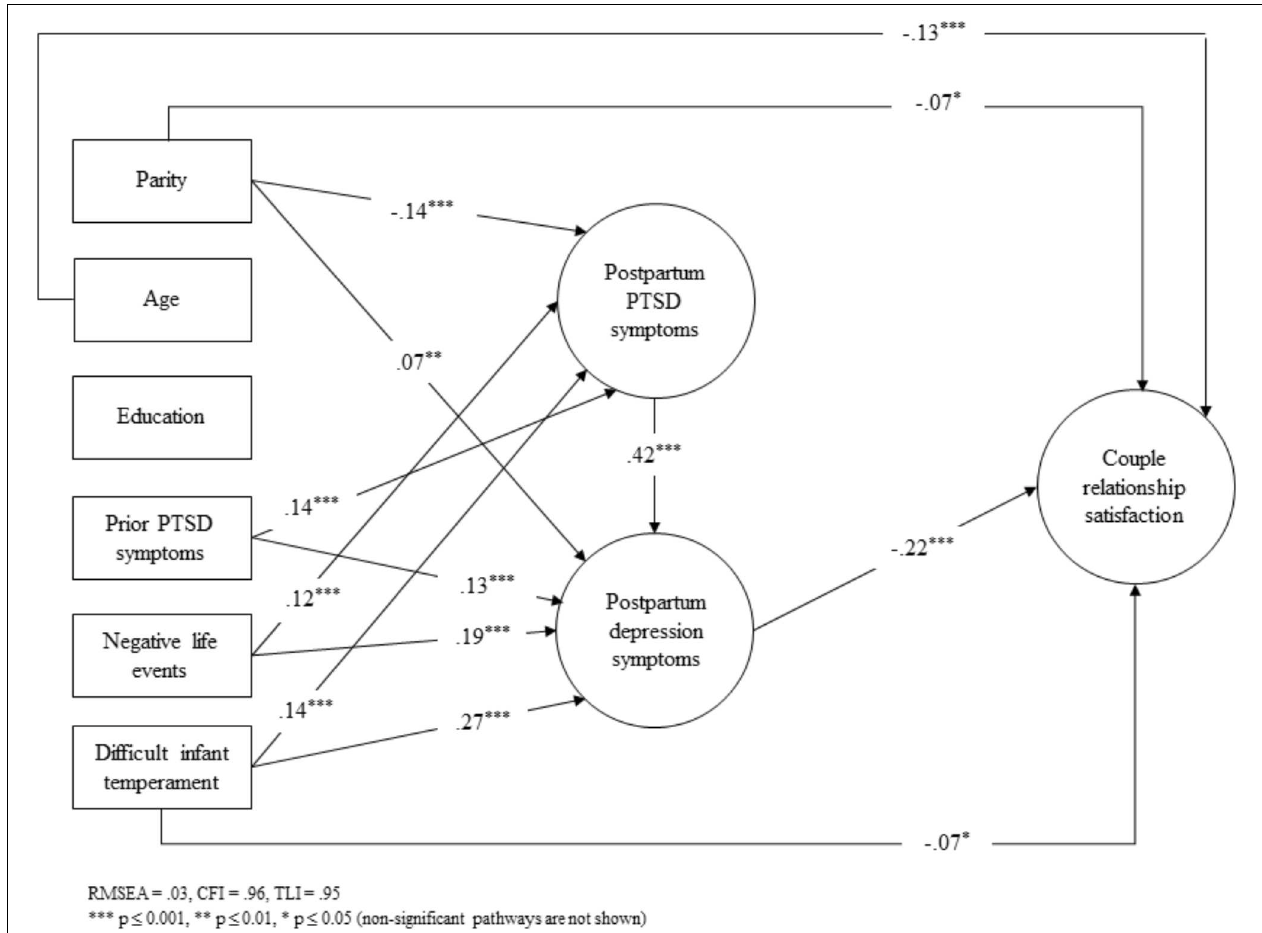
FIGURE 1 | Full mediation model predicting couple relationship satisfaction. Abbreviations: CFI, comparative fit index; EPDS, Edinburgh Postnatal Depression Scale; IES, Impact of Event Scale; PTSD, posttraumatic stress disorder; RMSEA, root mean square error of approximation; RS10, Relationship Satisfaction Scale; TLI, Tucker–Lewis